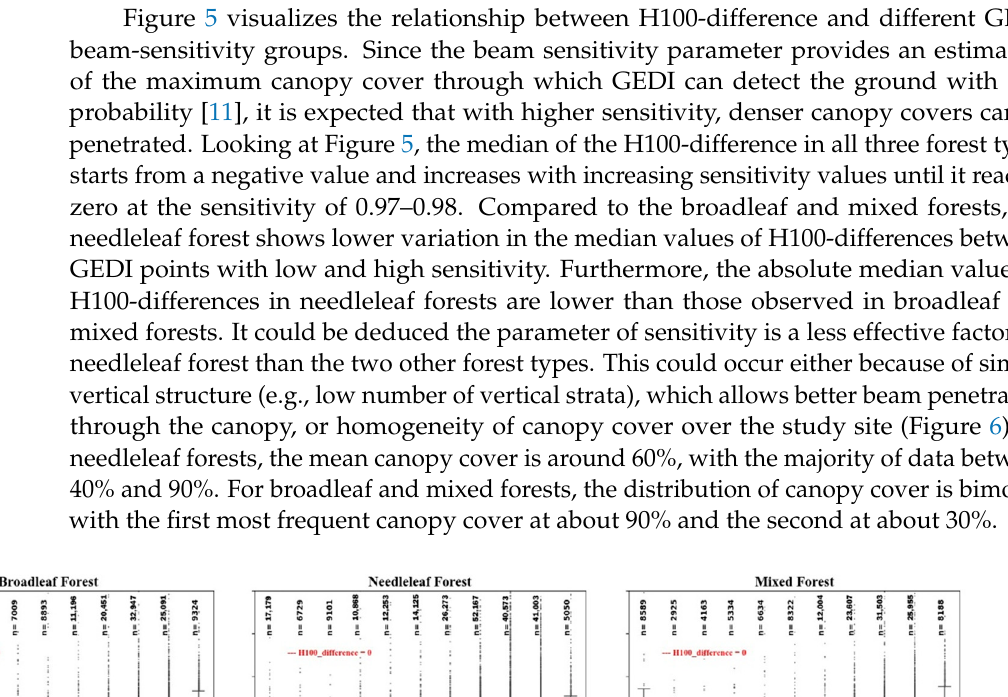
Figure 4. GEDI-H100 versus ALS-Hmax for algorithm group 2 in three forest types, including ( a ) broadleaf, ( b ) needleleaf, and ( c ) mixed.